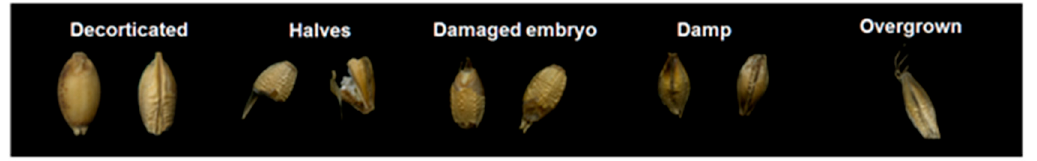
Figure 2. Examples of the types of BOJOS cultivar grain damages. Table 1. Contaminant content in the examined size fractions of malting barley of BOJOS variety [%].